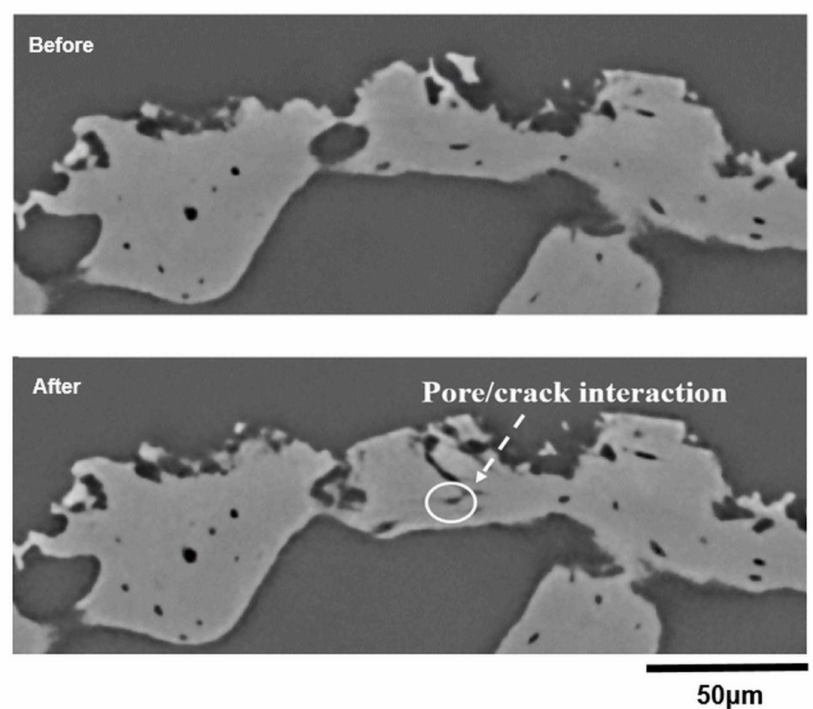
Figure 9. Individual slice images before and after indentation showing plastic deformation, collapse and cracking as a result of the indenter at a distance of 66 µ m from the indenter tip (see also animated sequences in supplementary video online).